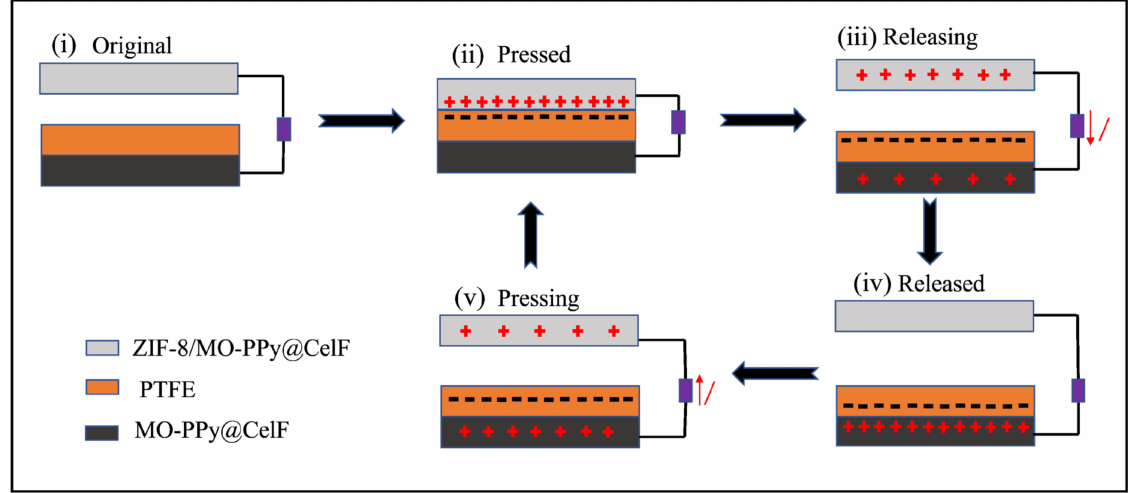
Figure 7. Schematic illustration of the TENG working